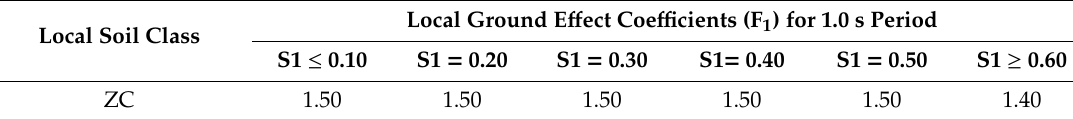
Table 5. Local soil e ff ect coe ffi cients for class ZC (F 1 )